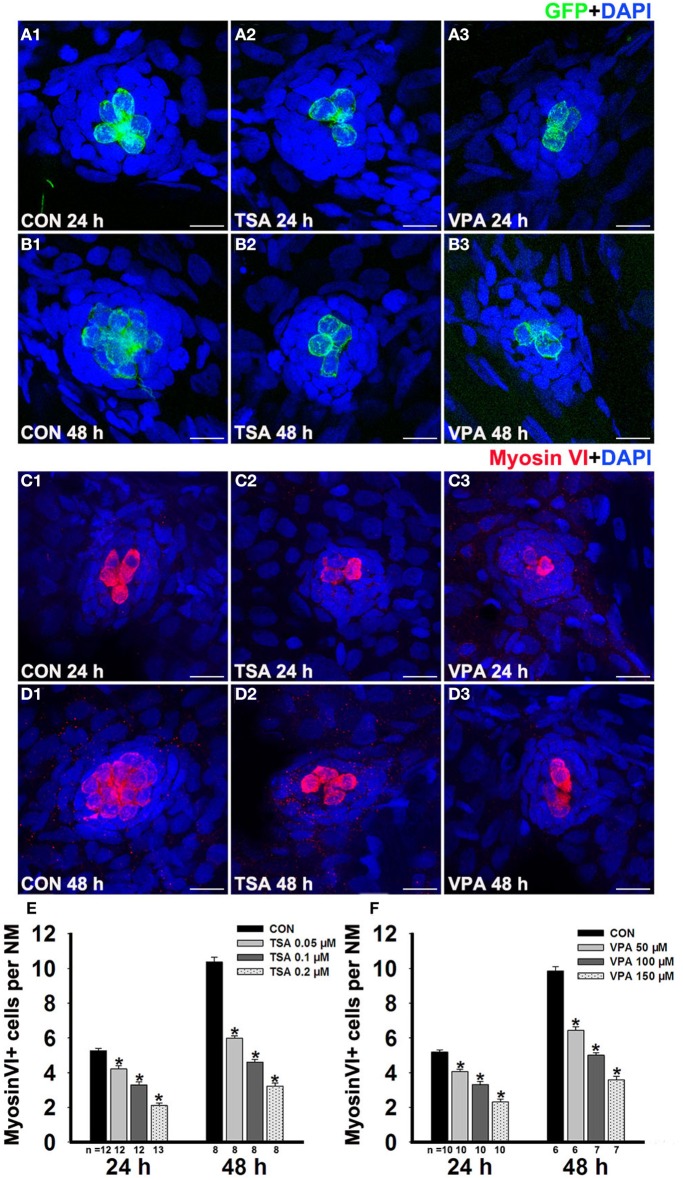
HDAC inhibitor treatment decreases regeneration of HCs in lateral line neuromasts. (A and B) We treated 5 dpf Tg(pou4f3:gap43-GFP) zebrafish with 400 μM neomycin for 1 h and then treated them for 24 h or 48 h with TSA or VPA and subsequently imaged GFP+ HCs (green). Nuclei are stained with DAPI and scale bars = 10 μm. (C and D) Lateral line HCs are stained with Myosin VI. (E and F) The average number of Myosin VI+ cells per neuromast (NM) in larvae treated with or without HDAC inhibitor for 24 h or 48 h after neomycin damage. Bars are mean ± s.e.m. and n = total number of embryos. *p < 0.05.